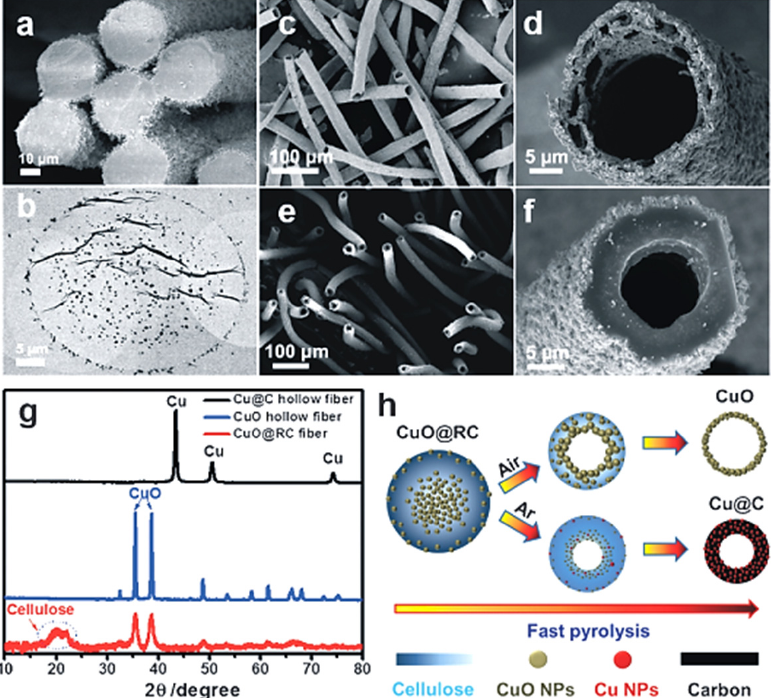
Figure 13. ( a ) The SEM and ( b ) TEM images of the CuO–RC filaments. ( c ), ( d ) SEM images of CuO- and ( e ), ( f ) SEM images of the Cu@C hollow fibers. ( g ) The XRD patterns of the CuO–RC fibers, CuO, and Cu–C hollow fibers. ( h ) The formation of CuO and Cu–C hollow fibers by the fast pyrolysis of CuO–RC filaments. CuO and Cu–C hollow fibers were obtained by the pyrolysis of CuO–RC filaments at 600 °C for 1 h in an air and argon atmosphere, respectively [ 259 ] . Copyright 2016 John Wiley & Sons Inc. Reproduced with permission.